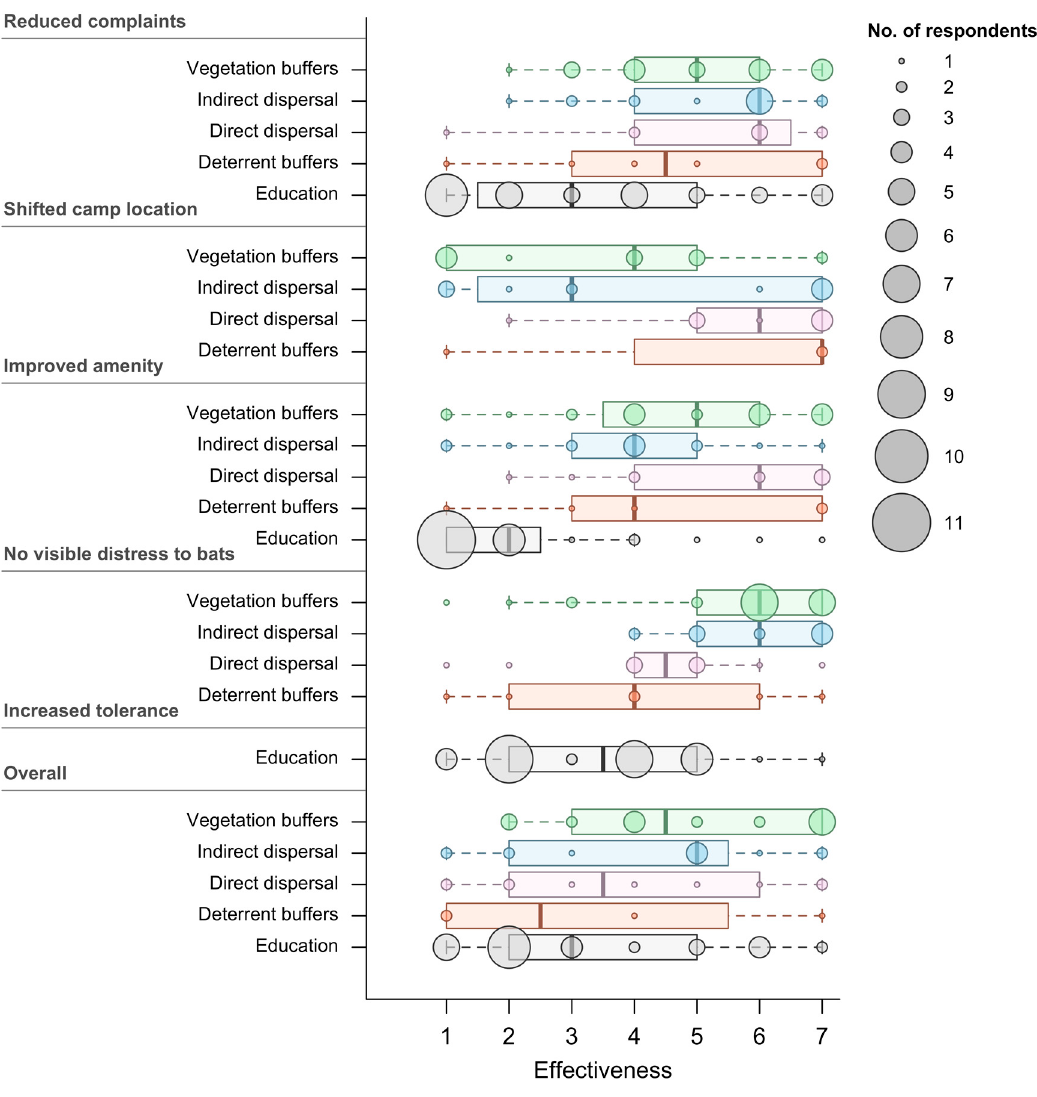
Figure 4. Perceived effectiveness of the five most commonly used management actions across a range of factors. Level of effectiveness ranges from 1 = not effective, 4 = moderately effective, and 7 = very effective.